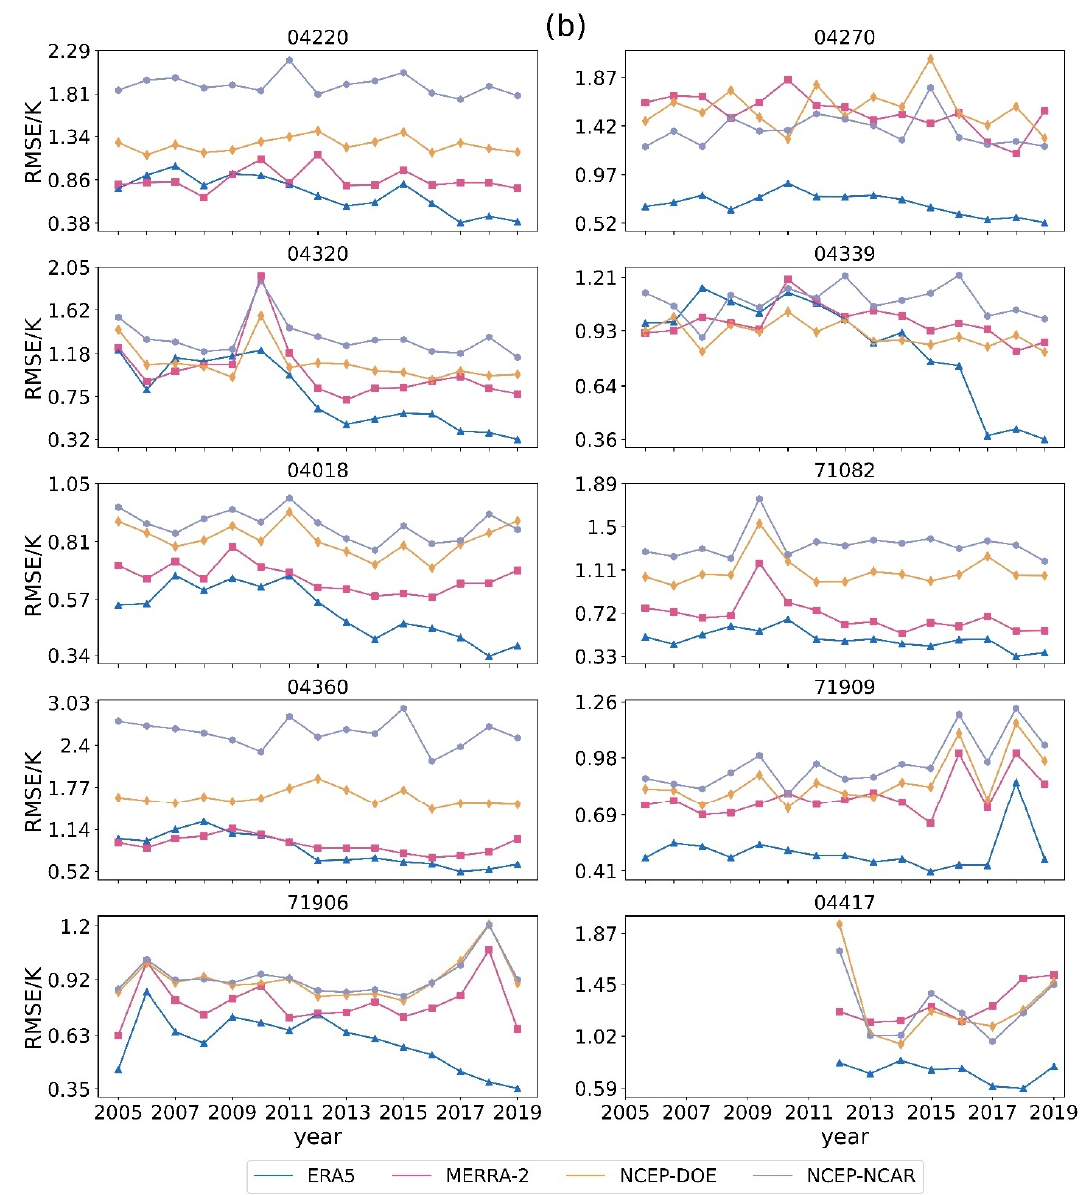
Figure 3. Annual mean ( a ) bias and ( b ) RMSE of T (cid:2923) at 10 stations from 2005 to 2019 calculated from four reanalysis data. four reanalysis